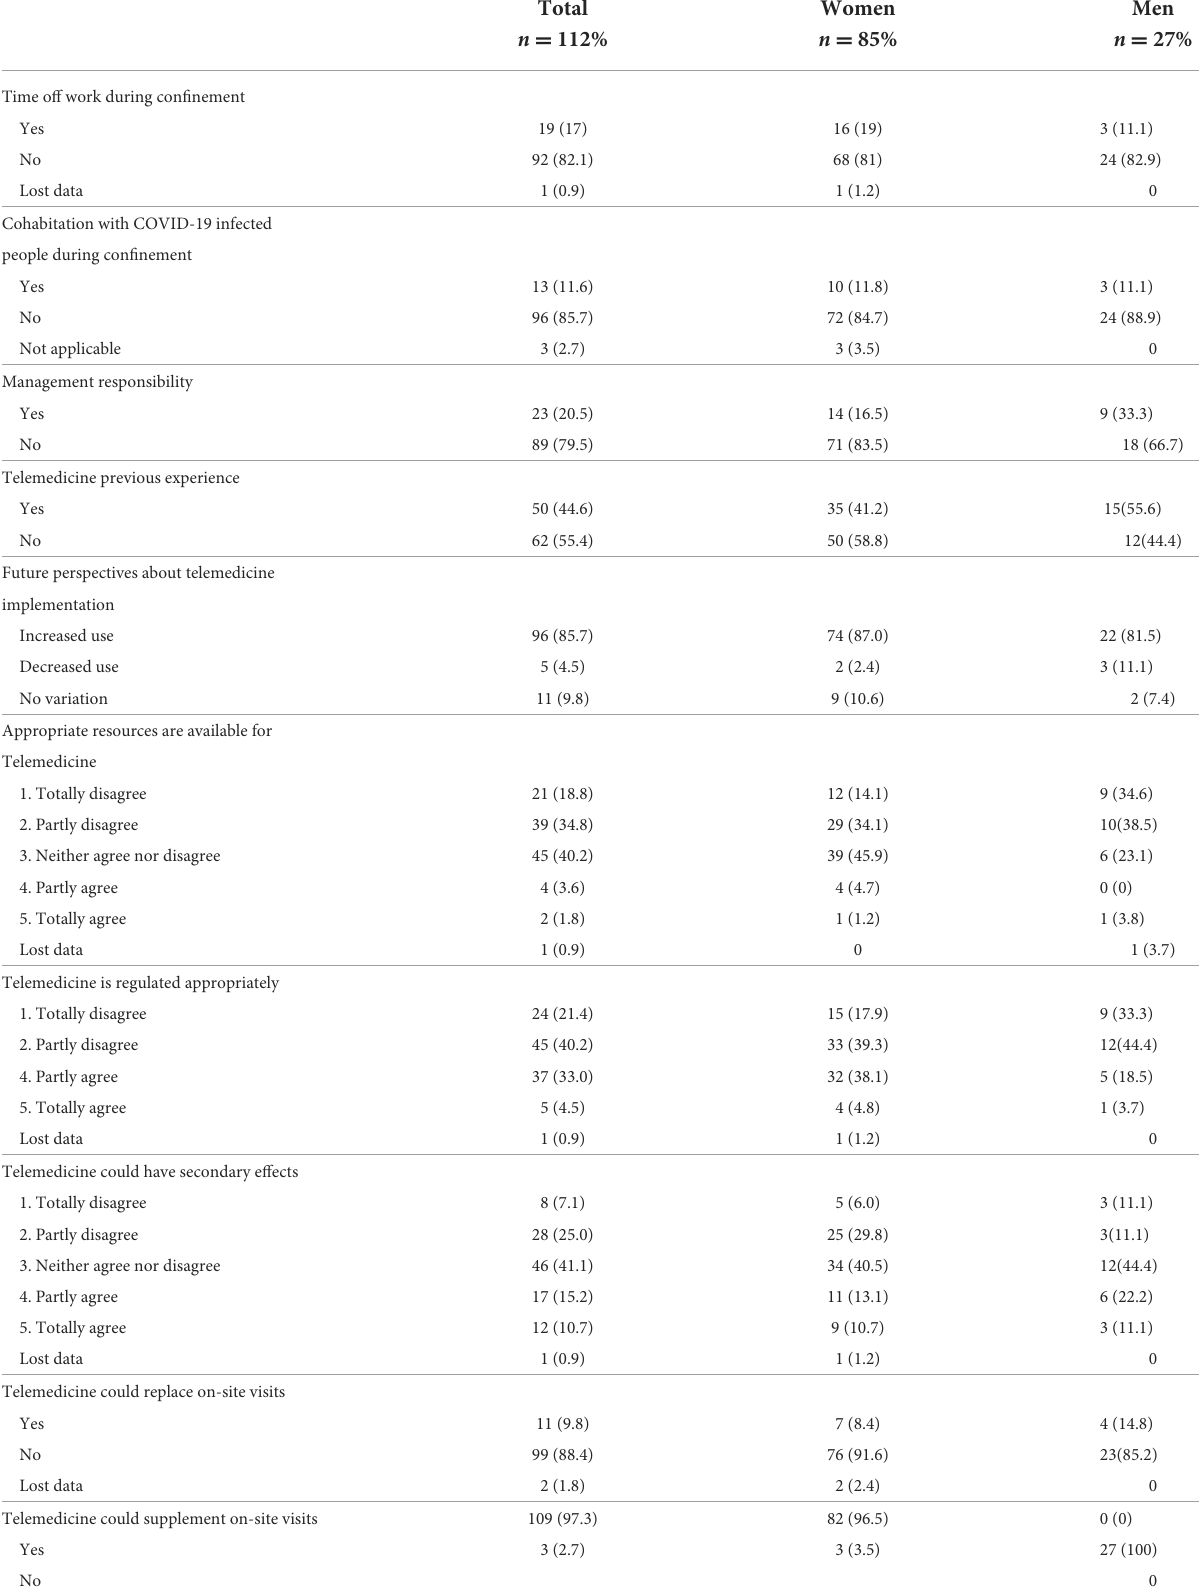
TABLE 2 Professional’s perceptions about